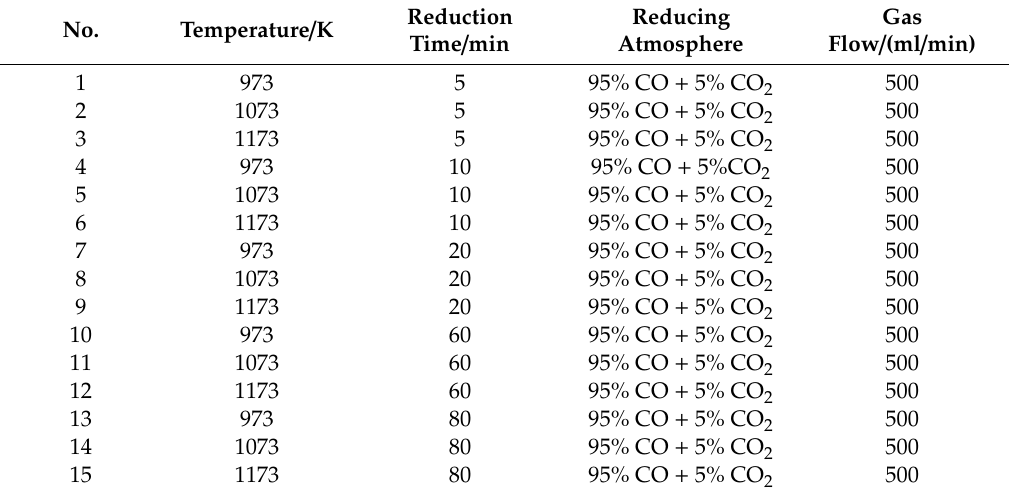
Table 2. Conditions of the online quenching